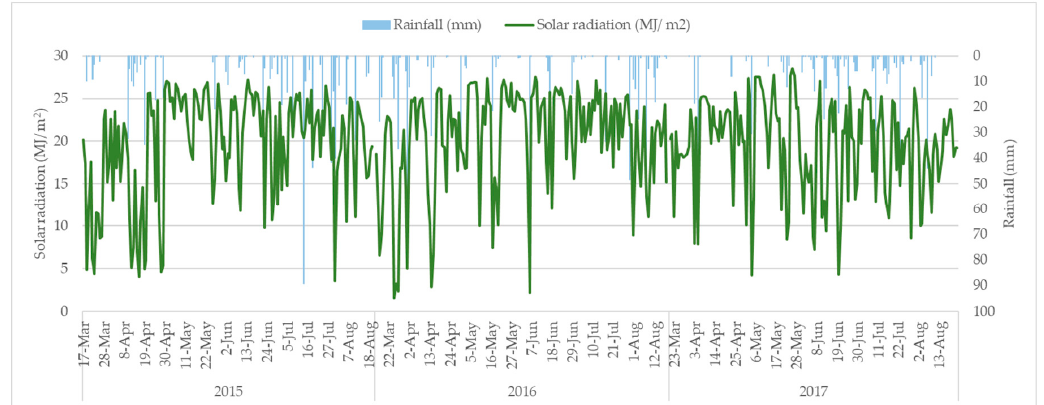
Figure 14. Rainfall (mm) and solar radiation (MJ/m 2 ) in the area of Tifton, GA, where RDC field is located during the maize growing seasons of 2015, 2016, and 2017.